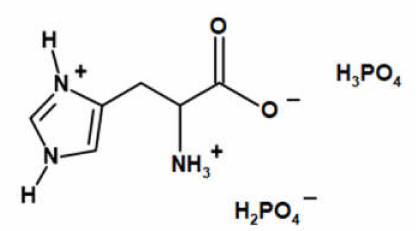
Figure 1. The chemical structure of LHP